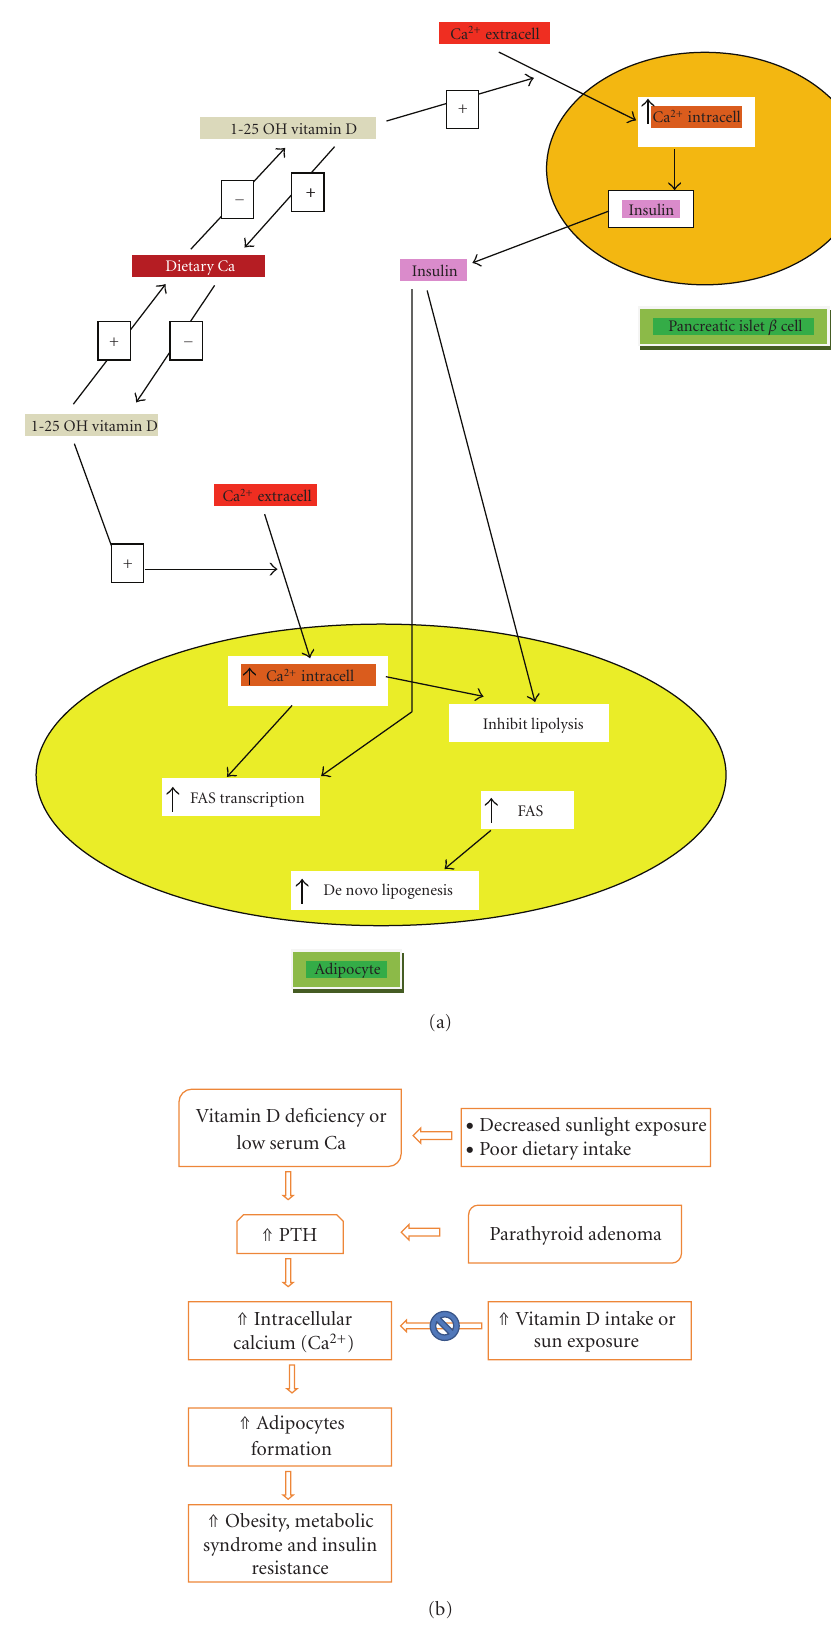
Figure 2: (a) Dietary and intracellular calcium + vitamin D modulation of adiposity. (b) Complex relationship between vitamin D, parathyroid hormone, intracellular calcium, and adipocyte